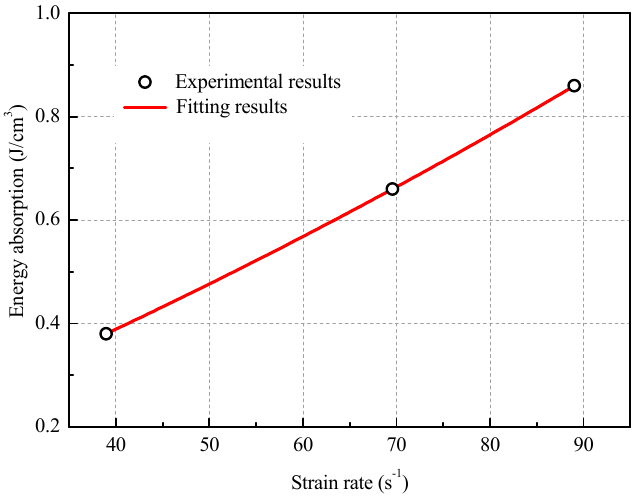
Figure 11. Variation of dynamic energy absorption with strain rate.